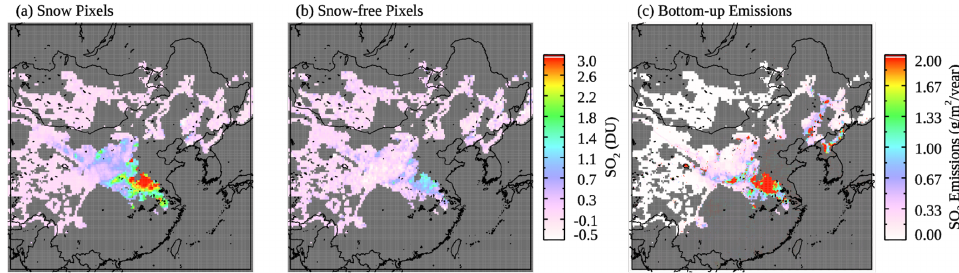
Figure 7. Mean SO 2 VCDs from the new anthropogenic SO 2 dataset in OMSO2 V2 for January to February 2008 over eastern China from pixels identified to be (a) cloud-free and covered by snow and (b) cloud-free (CRF < 0.1) and snow-free. Retrievals over snow pixels have enhanced signals over source areas that can be identified from (c) bottom-up emission estimates. Only grid cells having at least three observations from both snow and snow-free pixels during the 2-month period are shown.